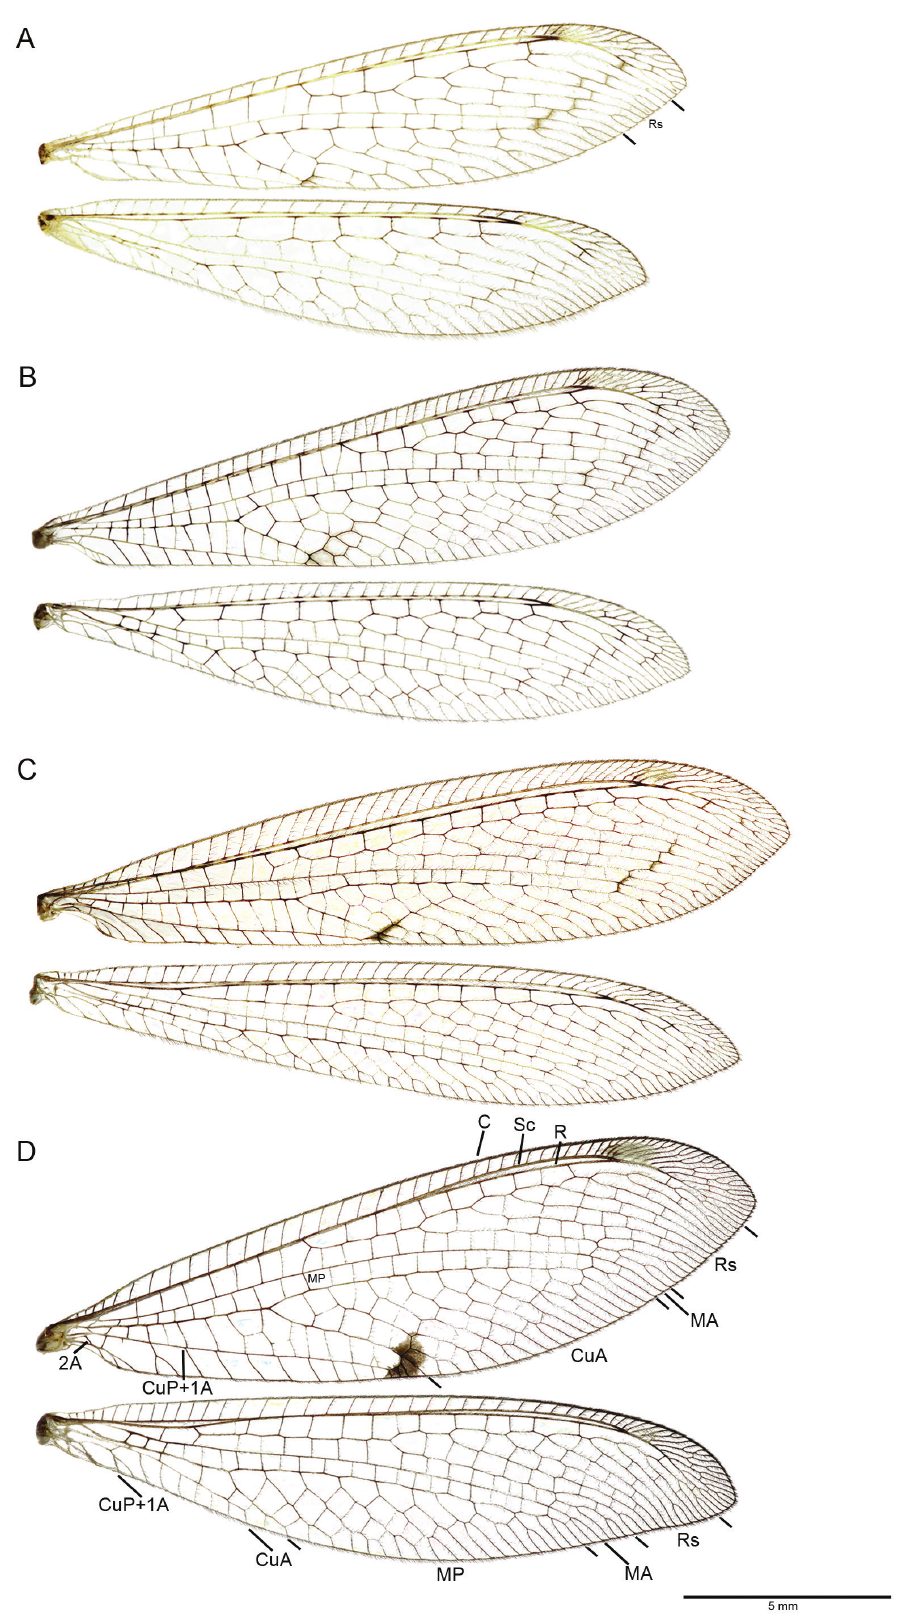
Figure 4. Wings of Gymnocnemia and Megistopus . A Gymnocnemia mirabilis [Oman, Jabal Shams]; B Gymnocnemia variegata [Italy, Lazio, Rome, type locality]; C Megistopus lucasi [Italy, Sardinia]; D Megistopus flavicornis [France, Gard]. Abbreviations: C – Costa, Sc – Subcosta, R – Radius, Rs – Radius sector, MA – Media anterior, MP – Media posterior, CuA – Cubitus